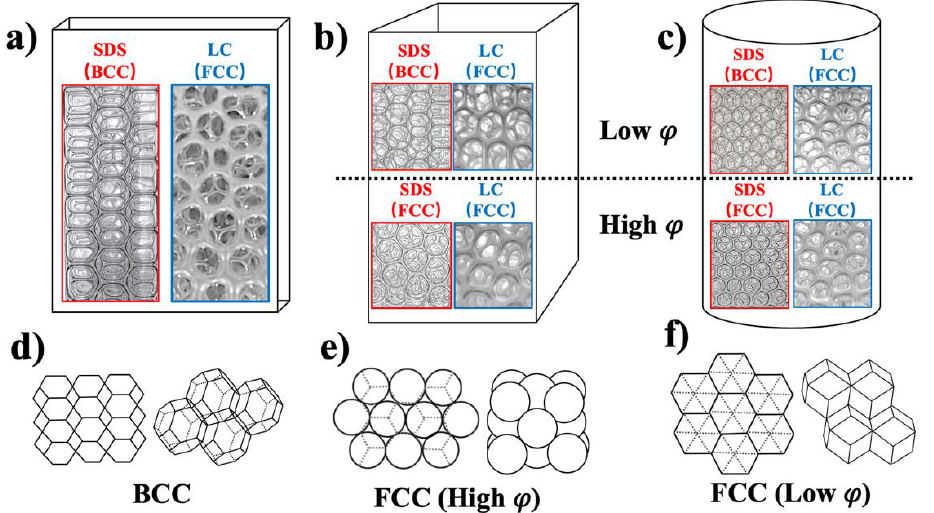
Figure 5. Three-dimensional structure of SDS and LC foams under geometric confinement. ( a ) Rec- tangular confinement: The SDS cells have a BCC structure, while the LC cells present an FCC struc- ture. ( b ) Square confinement: For the SDS foams, the 3D structure depends on their volume fraction . For low 𝜑 , the cells have a BCC structure, and for high 𝜑 , they present an FCC symmetry. The LC foam always shows an FCC structure, independently of 𝜑 or the geometry of confinement. ( c )